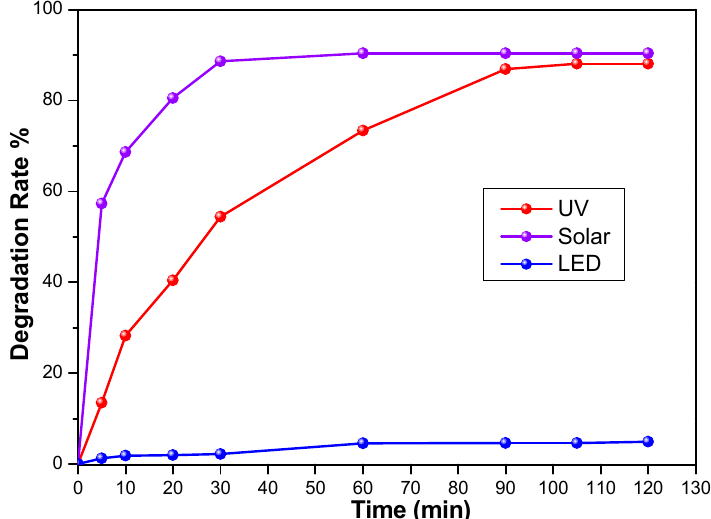
Figure 9. The photocatalytic activity of ZnBi 2 O 4 under UV, sunlight and LED lamp: CCFX = 10 ppm, pH ~6, T = 25 °C and catalyst dose = 1 g/L.